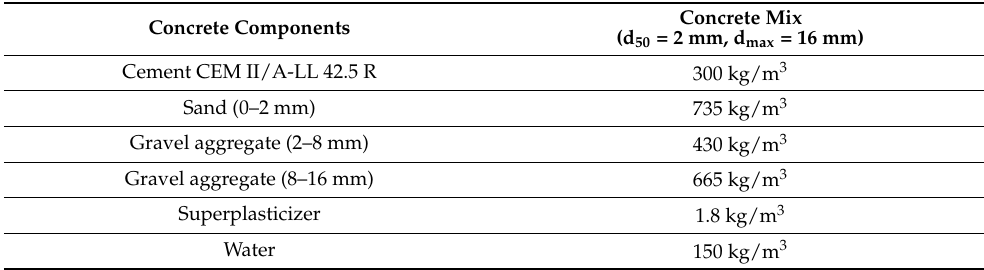
Table 1. Concrete recipe details.